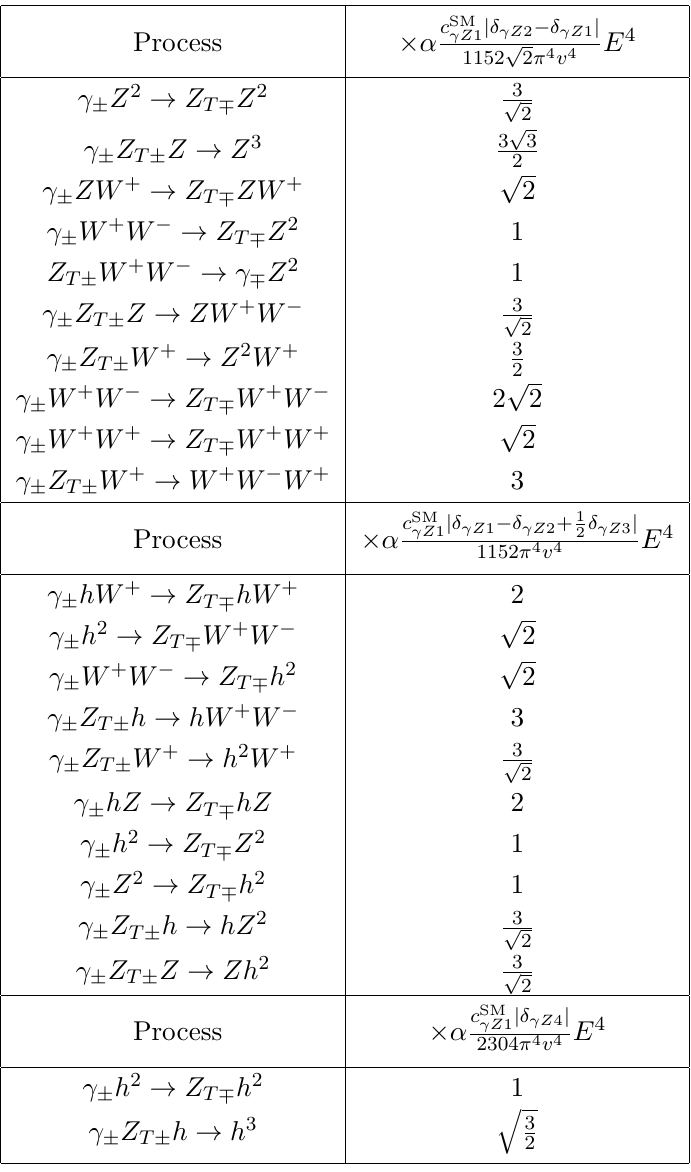
Table 7 . | ˆ M | of the 6-body unitarity-violating processes arising from the modification of the Higgs coupling to γZ .